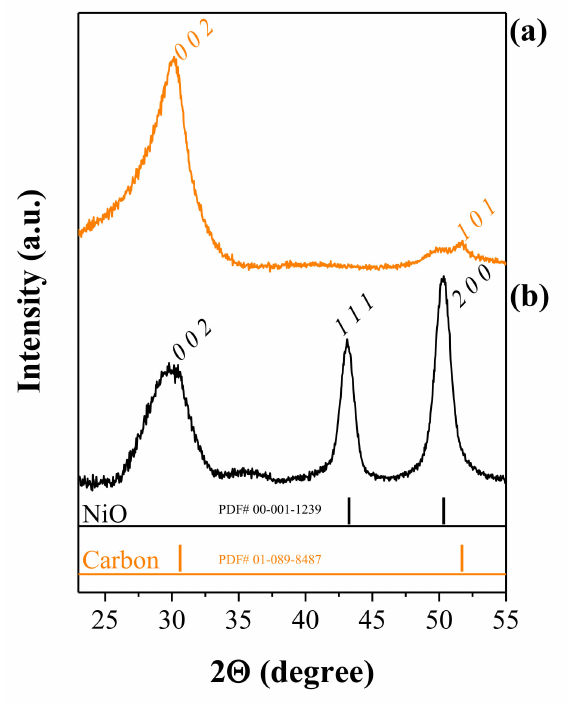
Figure 4. XRD patterns of ( a ) CNFs and ( b )